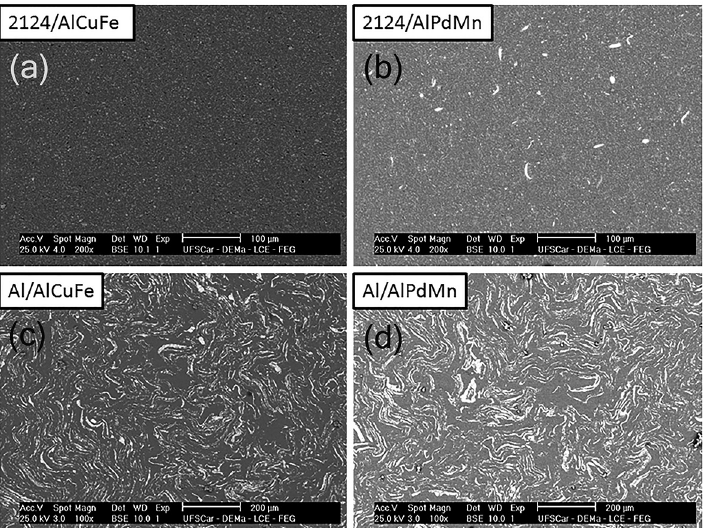
Figure 5: SEM images of the aluminum/quasicrystal and 2124 aluminum alloy/quasicrystal. (a) 2124/AlCuFe. (b) 2124/AlPdMn. (c) Al/AlCuFe. (d)